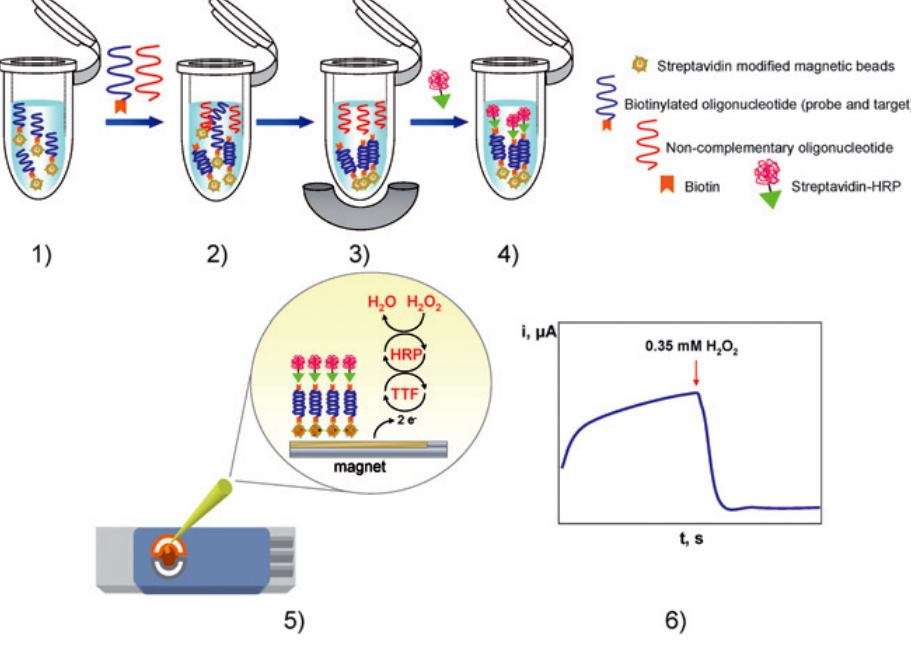
Figure 4. Schematic representation of the enzyme amplification protocol: (1) probe- modified magnetic beads washing step; (2) hybridization with the target lacZ gene probe; (3) hybrid-modified magnetic beads separation and non-complementary oligonucleotide extraction; (4) enzymatic labelling with streptavidin-HRP; (5) hybrid-modified magnetic beads deposition on the TTF-Au/SPEs; (6) amperometric detection of the mediated reduction of H O with TTF (reproduced, with permission, from reference 2 2